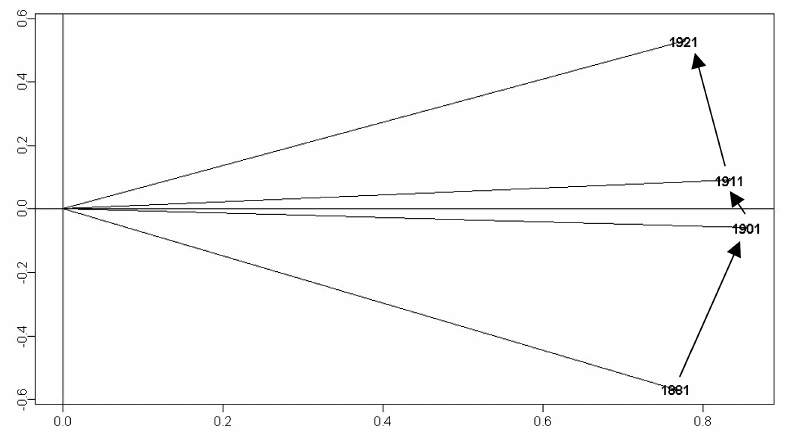
Figure 4 − Similarity structure of the four scalar-product